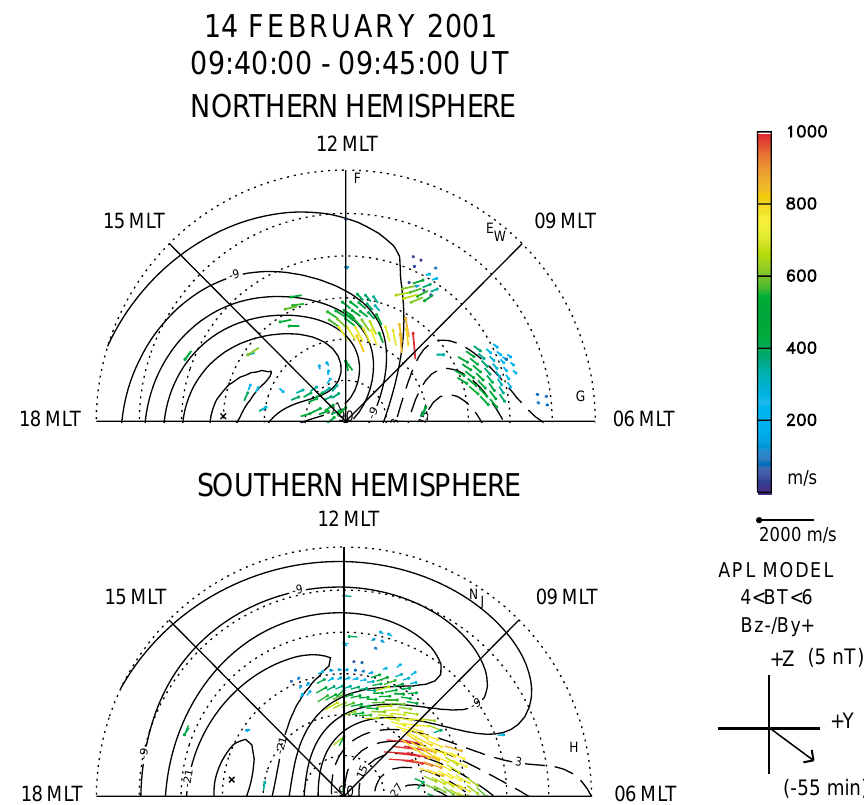
Fig. 7. Streamlines and vectors of the ionospheric flow derived from SuperDARN velocity measurements in the dayside Northern (upper panel) and Southern (lower panel) Hemisphere ionosphere, obtained from the “map-potential” technique described in the text. Solid (dashed) black lines represent streamlines corresponding to negative (positive) equipotential contours. The data are presented on a geomagnetic grid with lines of constant magnetic latitude at 5 ◦ increments indicated by the dotted concentric circles. Magnetic local time meridians are represented by solid lines at 06, 09, 12, 15, and 18 MLT. The velocity vectors are scaled and colour-coded to indicate flow speed as described in the key to the right. In addition, in the lower right corner we indicate the flow model employed to stabilize the potential solution in regions where no data are available, obtained from the statistical study of Ruohoniemi and Greenwald (1996).